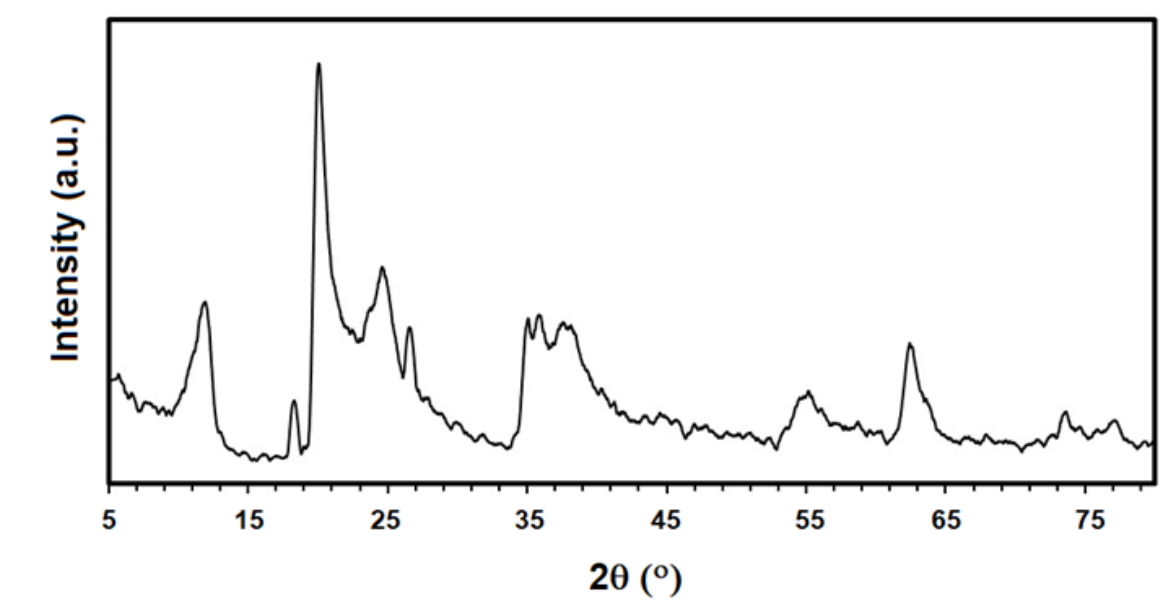
Figure 3. X-ray diffraction (XRD) pattern of Halloysite nanoclay.